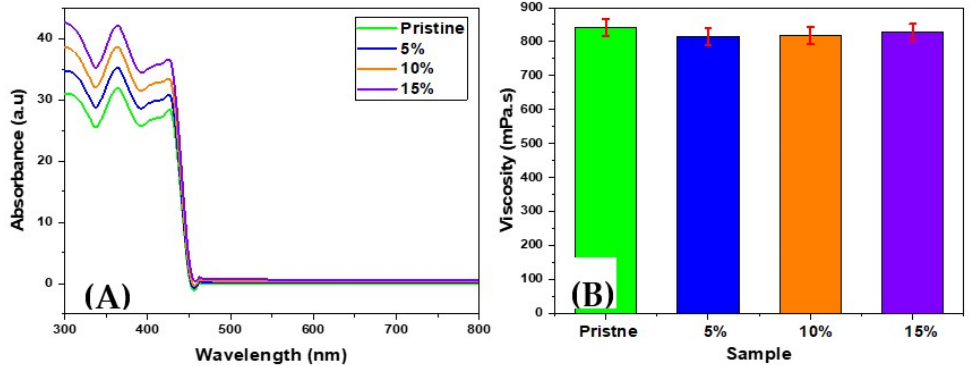
Figure 3. Absorbance spectra of different concentrations of the AgNPs-modified resin ( A ); viscosity test of the modified samples (liquid) in comparison with the pristine samples ( B ).